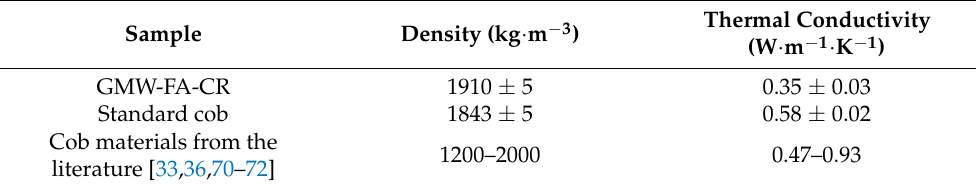
Table 9. Thermal Conductivity of GWM-FA-CR Specimen and the Standard Cob Compared to Those of Cob Building Materials from the